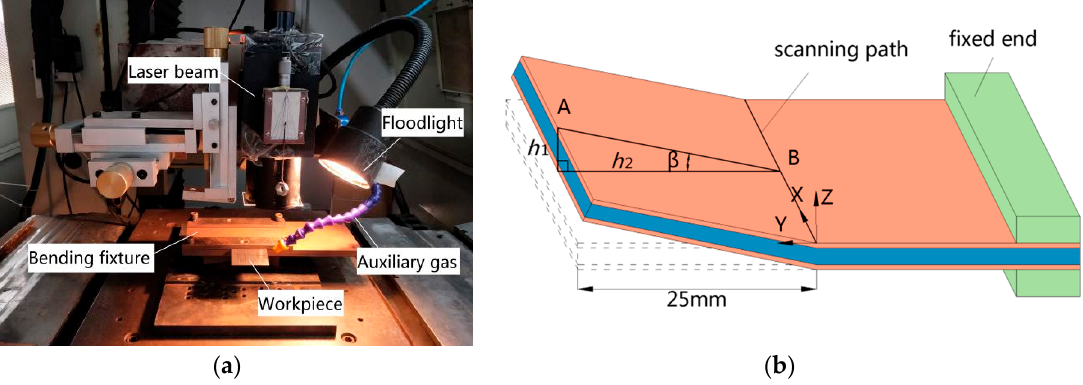
Figure 12. Experimental devices of laser bending: ( a ) Machine of laser bending ; ( b ) schematic diagram of laser bending. Table 1. Simulation conditions under different laser parameters.